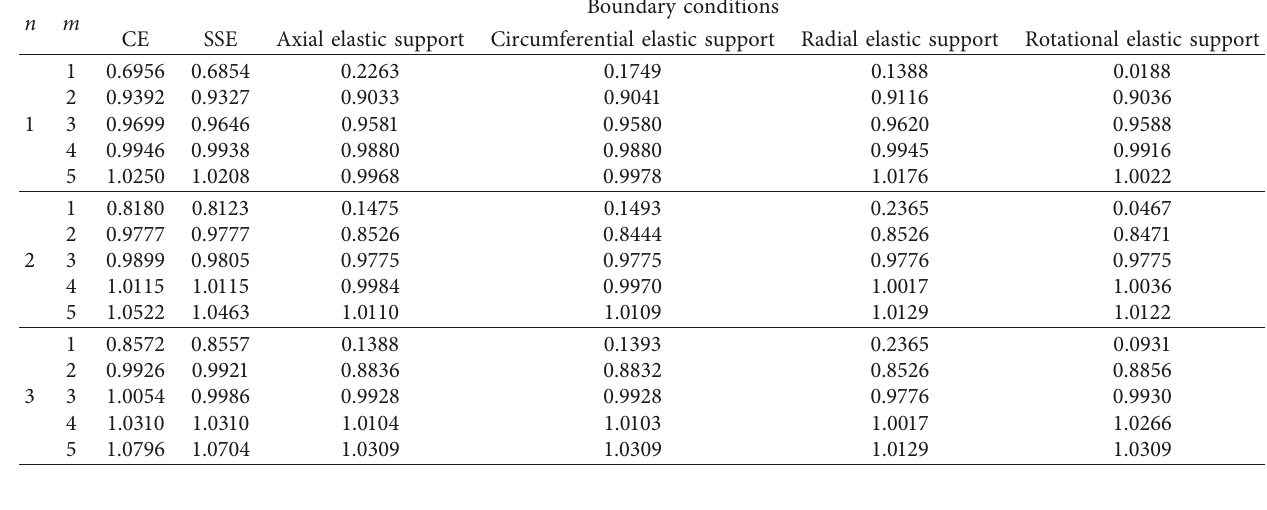
Table 10: Nondimensional frequency parameter of stepped hemispherical cap with different edge conditions.